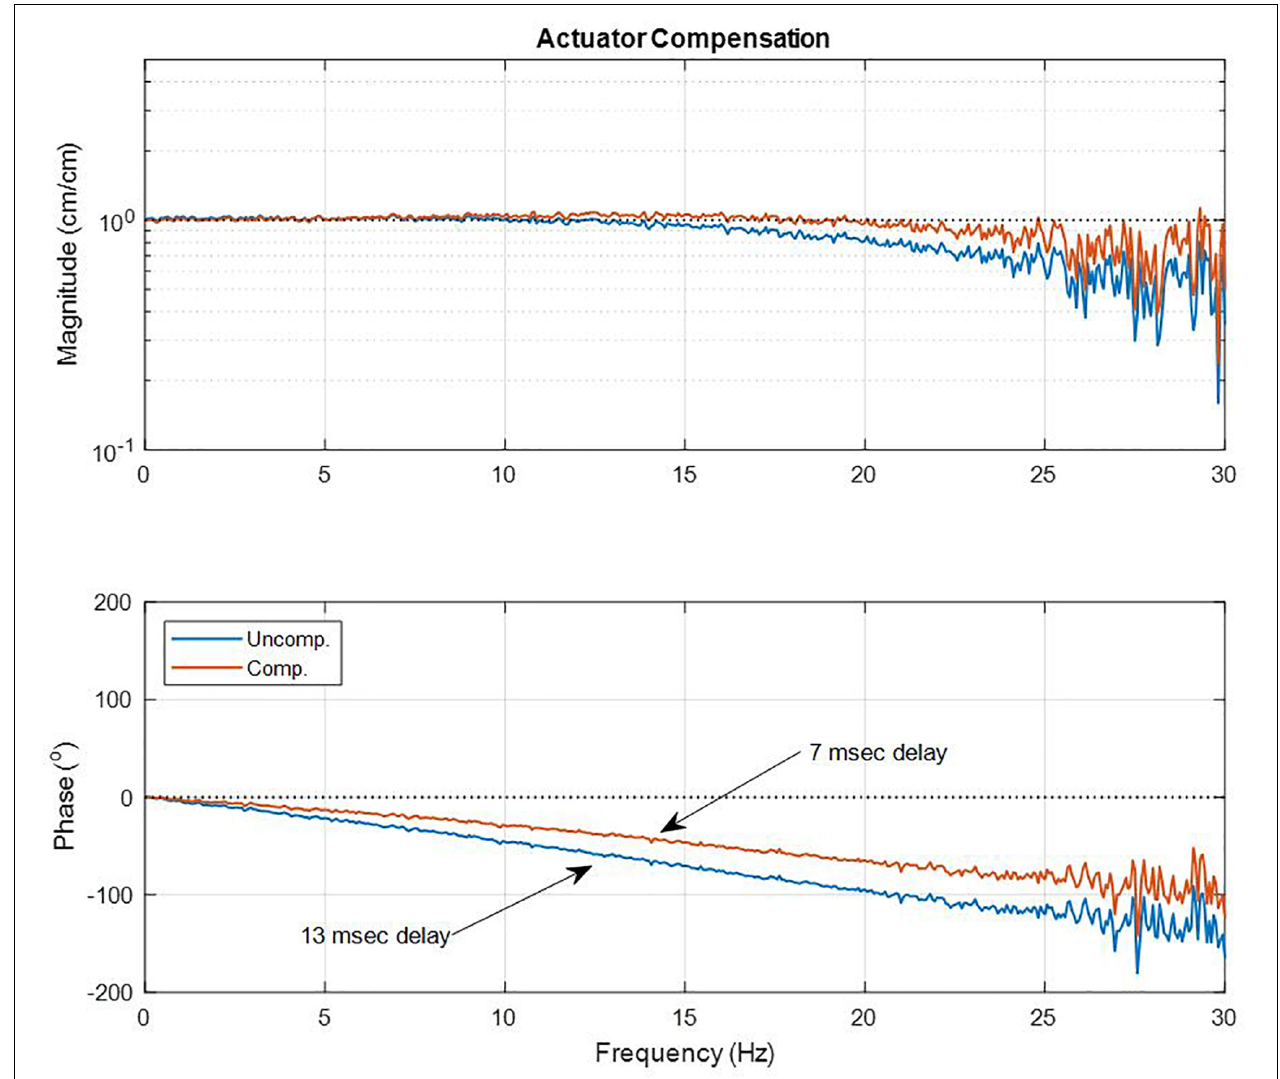
FIGURE 5 | Comparison of uncompensated vs compensated actuator